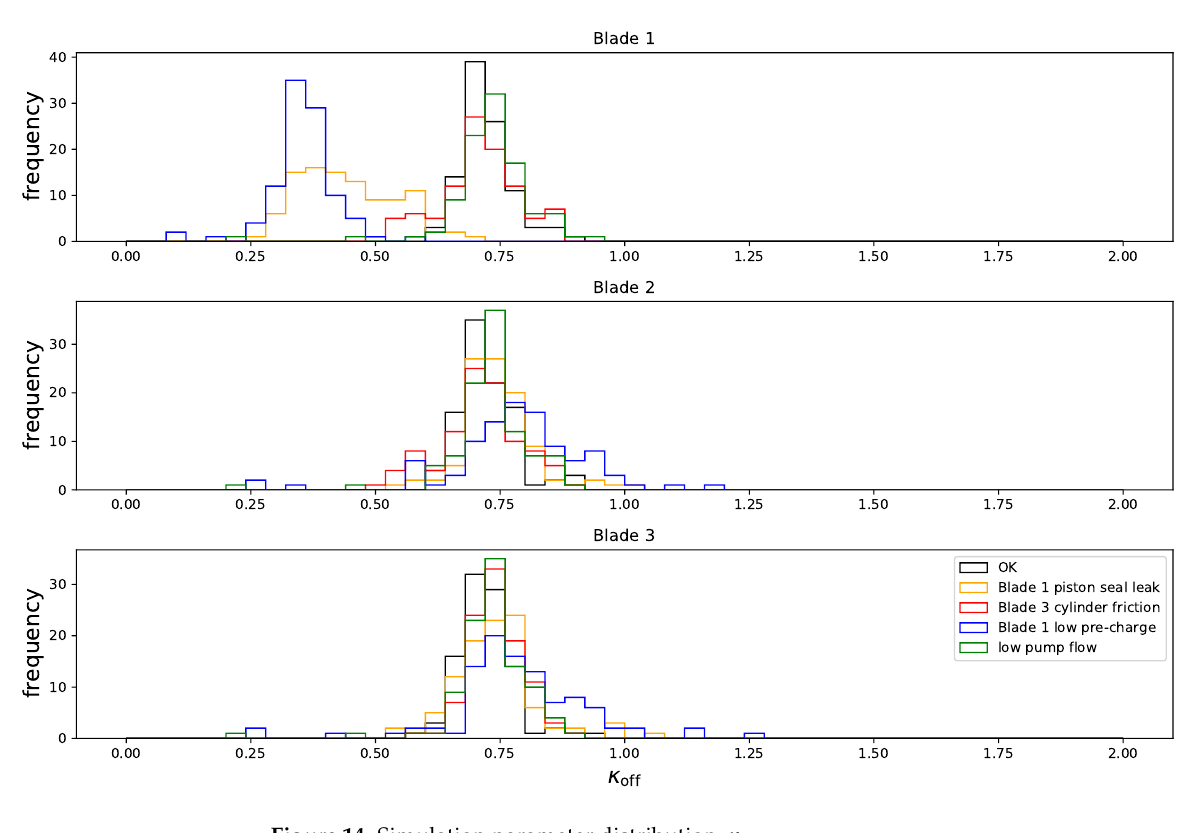
Figure 14. Simulation parameter distribution, κ off .